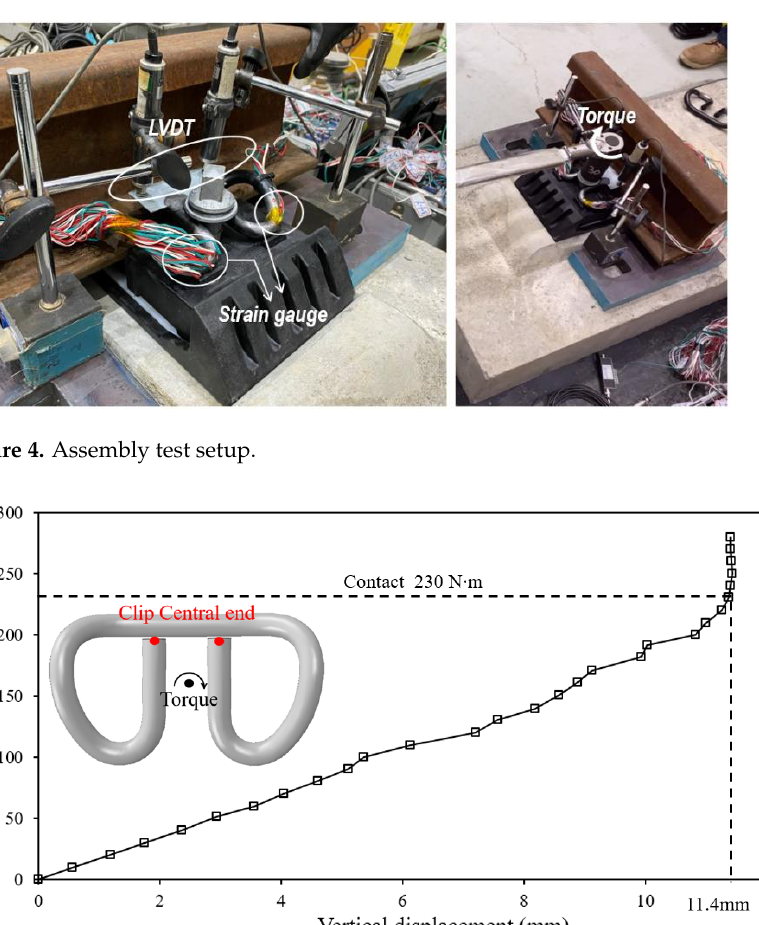
8.5 Figure 3. Stress versus strain curve (for coupon specimen 1). 2.2. Assembly Test An assembly test was performed in the laboratory to evaluate the structural behavior